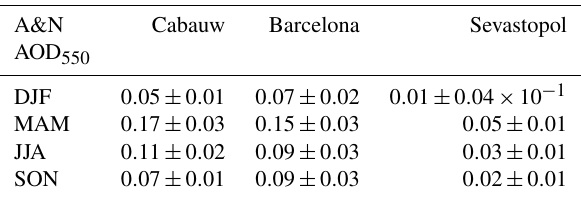
Table 4. Mean seasonal A&N AOD 550 simulated by the model (NIT simulation) at three AERONET stations (Cabauw, Barcelona and Sevastopol) over the period